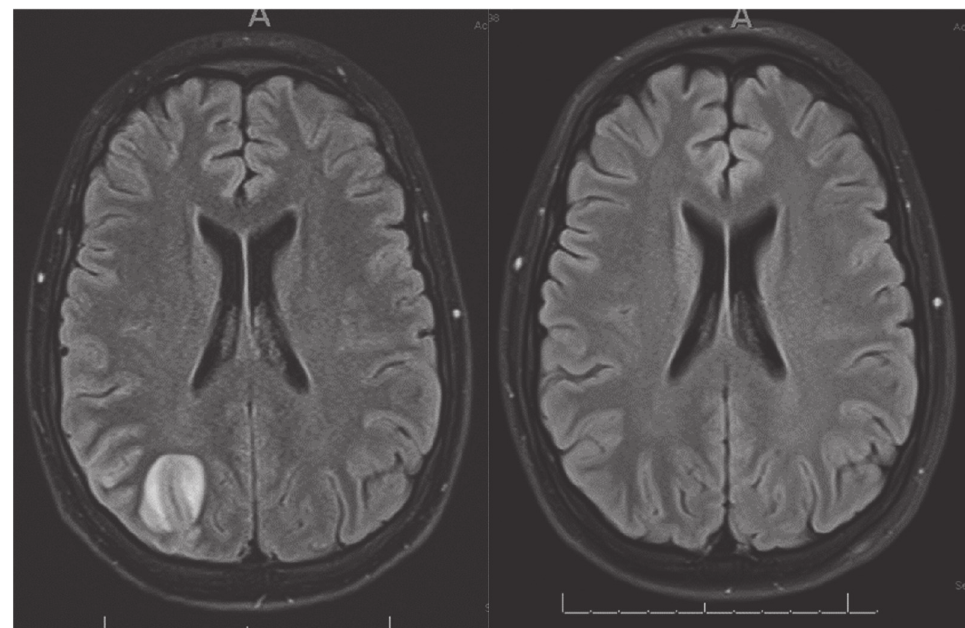
Figure 1: MRI brain at time of relapse (August 2019), on the left, demonstrating a 3.4 cm enhancing lesion within the parietal region with associated leptomeningeal enhancement. On the right, a repeat MRI brain (January 2020) after 3 months on alectinib monotherapy showing resolution of lesion and leptomeningeal enhancement.